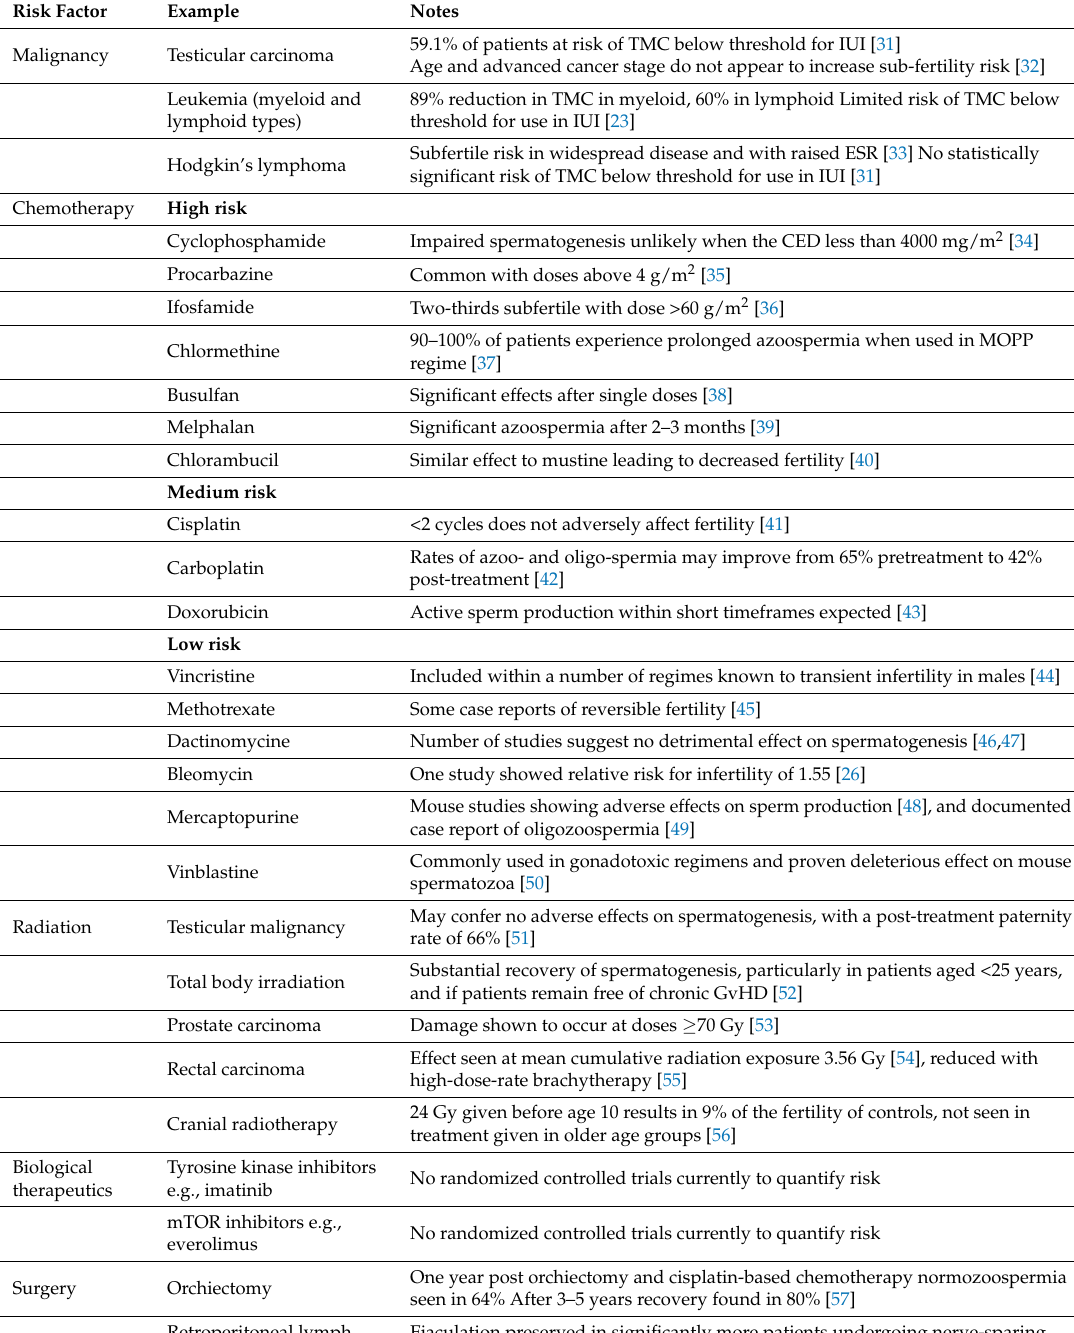
Risk factors for infertility in men with cancer. TMC—total motile